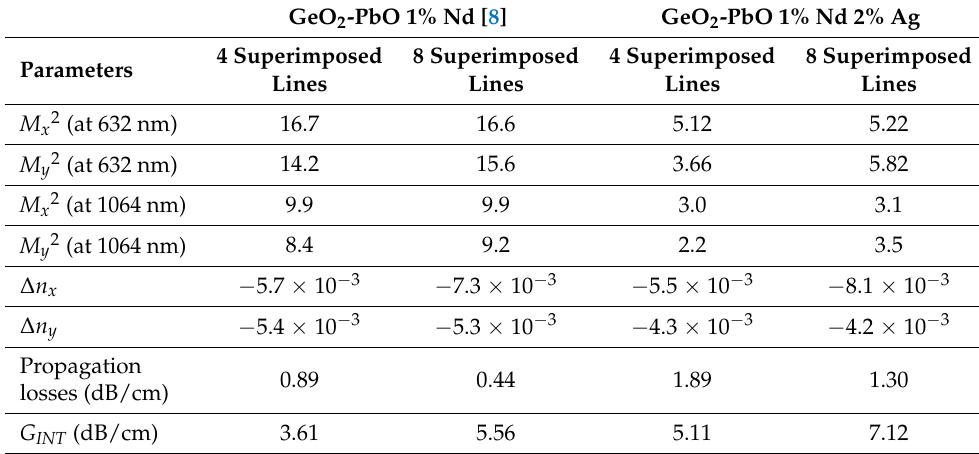
Table 2. Results of M x 2 , M y 2 , Δ n x , Δ n y , propagation losses and G INT (pulse energy of 30 µJ and pro- cessing speed of 0.5 mm/s).